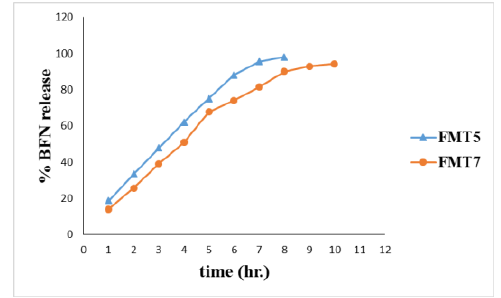
Figure (11) Effect of carbopol 934 p concentration on the % drug release in 0.1 N HCl (pH 1.2) at 37ºC Kinetic analysis of BFN release data from FMT 7 floating microsponge tablets The release of BFN from floating microsponge tablet FMT7 obeyed Higuchi- release as their R 2 values gave higher results.